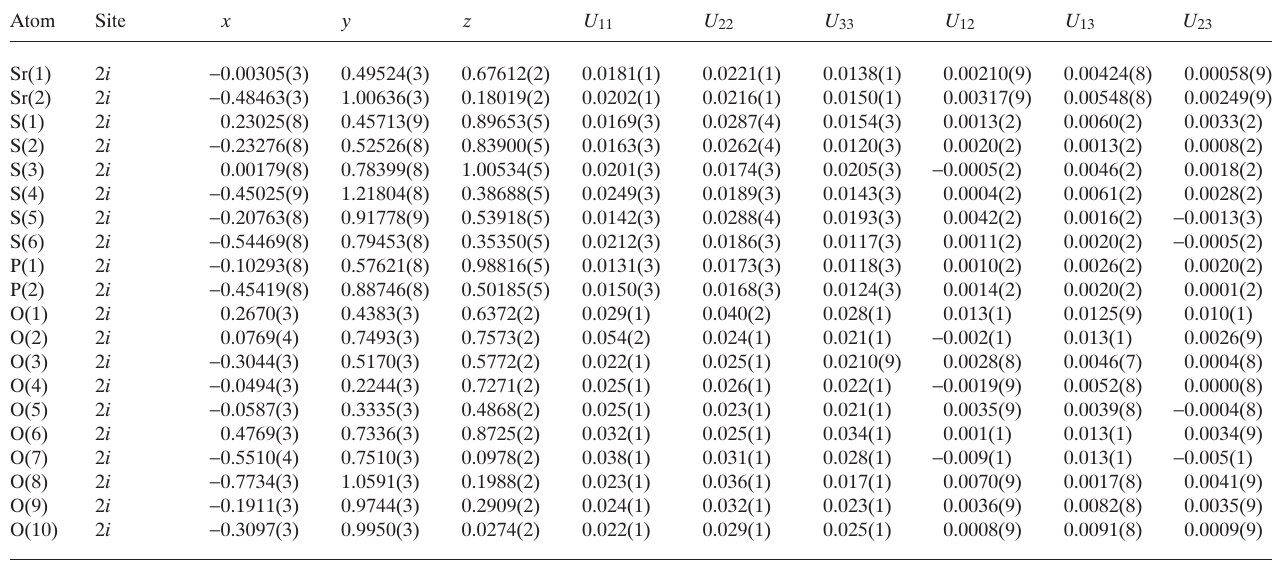
Table 3. Atomic coordinates and displacement parameters (in Å 2 ) .